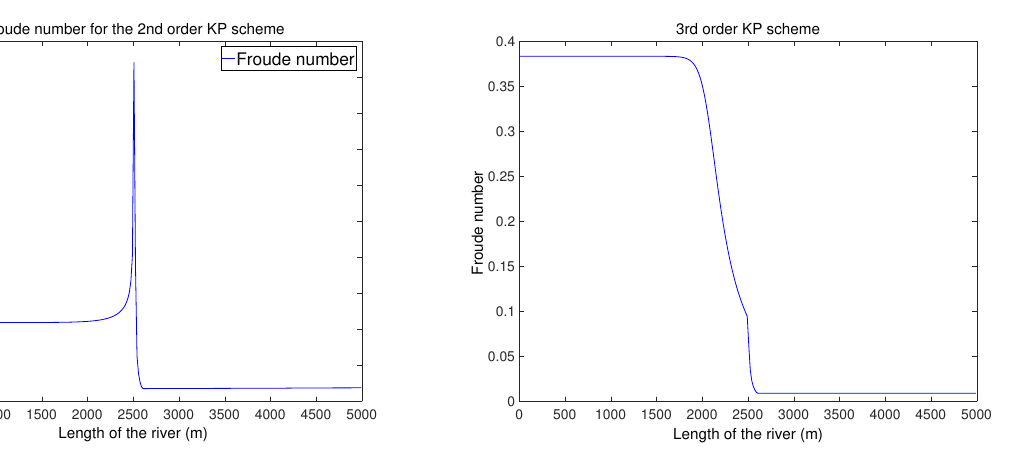
Figure 20: F r number for 2 nd order KP scheme. Figure 21: F r number for 3 rd order KP